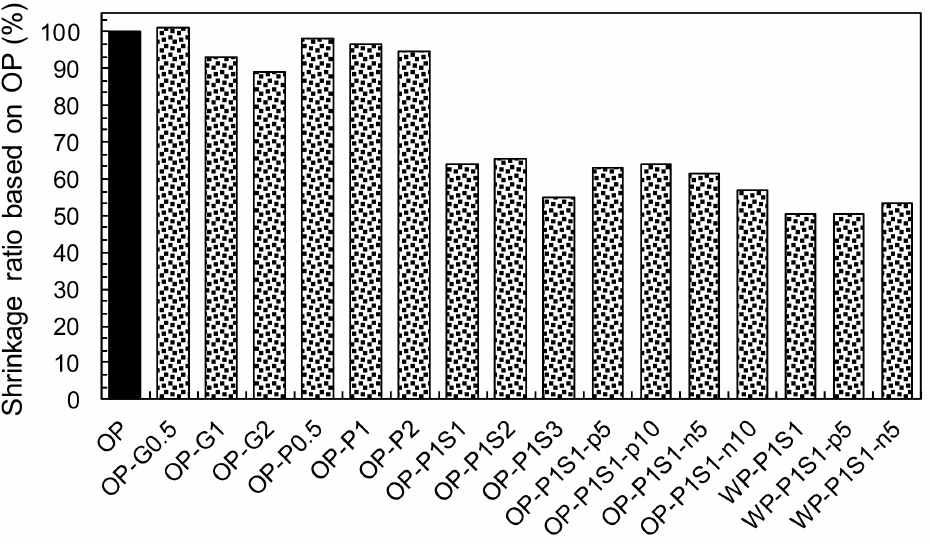
Figure 11. Summary of the 30-day shrinkage ratios based on the OP